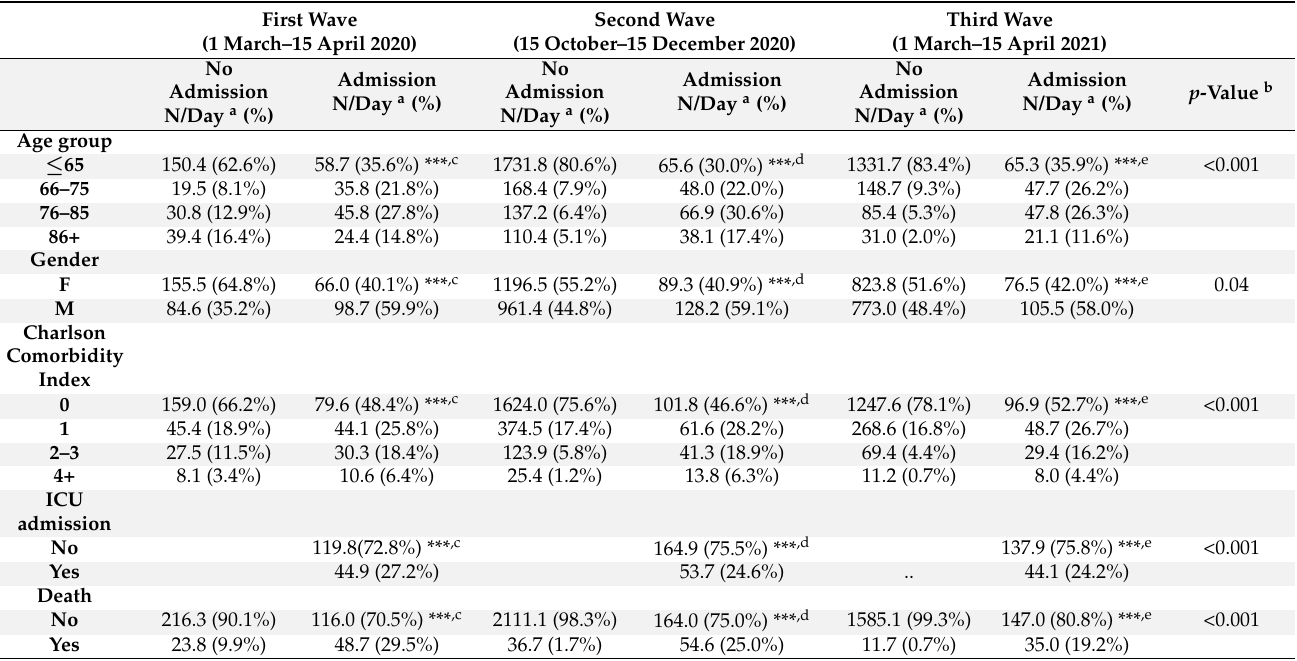
Table 2. Demographic characteristics, comorbid conditions, intensive care unit (ICU) admission, and death from COVID-19 of subjects tested positive for SARS-CoV-2, stratifying by hospitalization and waves.